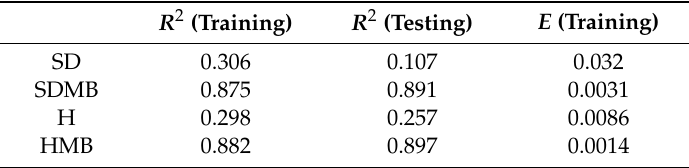
Table 1. Comparison results in terms of R 2 and cost ( E ).